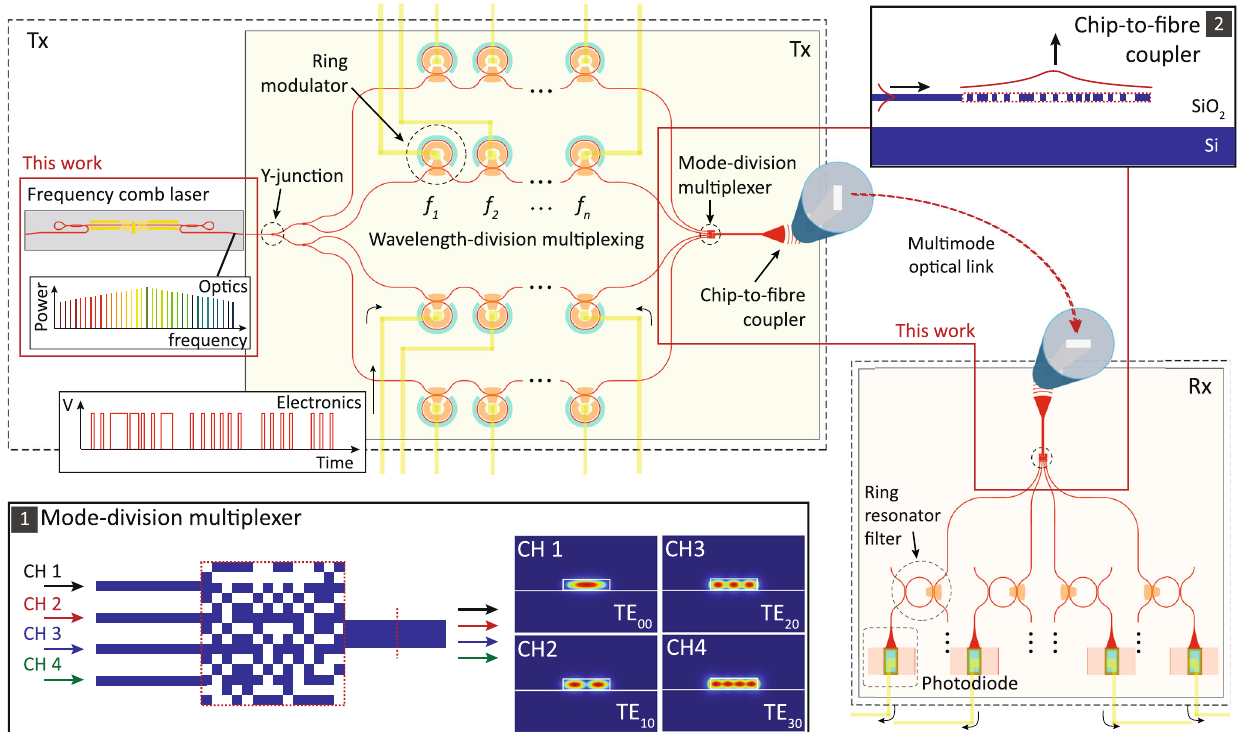
Fig. 1 | An optical transmitter using the multi-dimensional multiplexing prin- ciple of chip-to-chip WDM-MDM data transmission. A frequency comb laser is evenly distributed to individual WDM transmitters (e.g. cascaded ring modulators 39 ) using two-stage Y-junction splitters. The multi-frequency data from each WDM transmitter are routed into spatial modes of a multimode waveguide using an MDM multiplexer (Inset 1). The optical data can then be transmitted